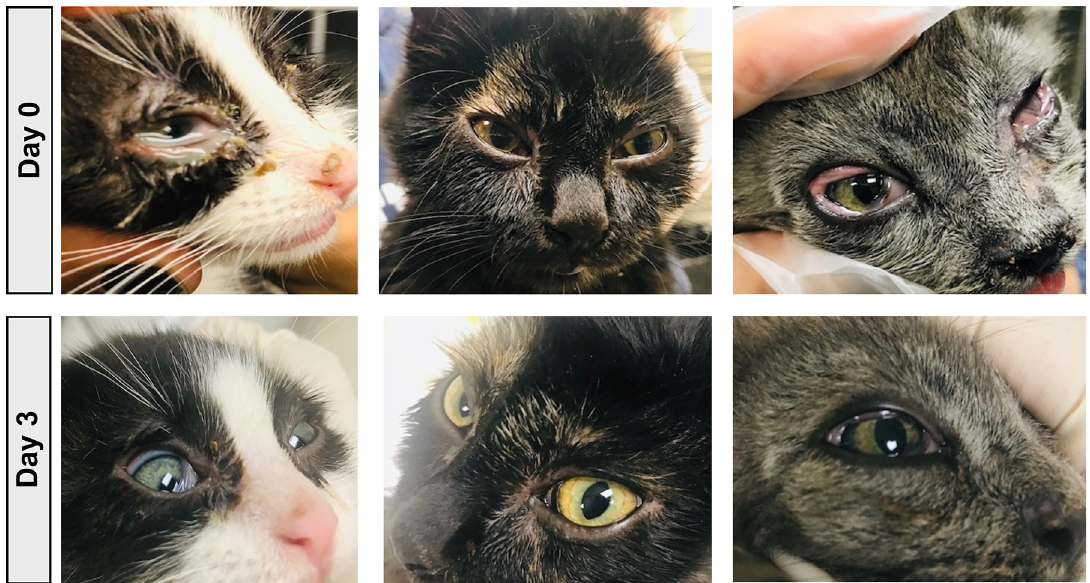
Fig 5. Response to treatment in 3 cats with suspected naturally occurring FHV-1 surface ocular infections. Cats with naturally- occurring surface ocular infections (conjunctivitis, keratitis) with FHV-1 and in some cases multiple pathogens were treated twice daily with LTAC nanoparticle eye drops (1 drop per eye), as noted in Methods, using an eye dropper to dispense the nanoparticles in solution. For 11 of the 13 treated eyes (Table 2), a positive response (partial or complete resolution of ocular inflammation and lesions) was observed by day 7 of treatment. The median, mean, and ranges for time to treatment responses were 1 day, 2.18 days (s.d. = 1.7 days), and 1–5 days, respectively. Only one eye failed to respond by Day 7 and that eye was positive by PCR for FHV-1, FCV, and Mycoplasma